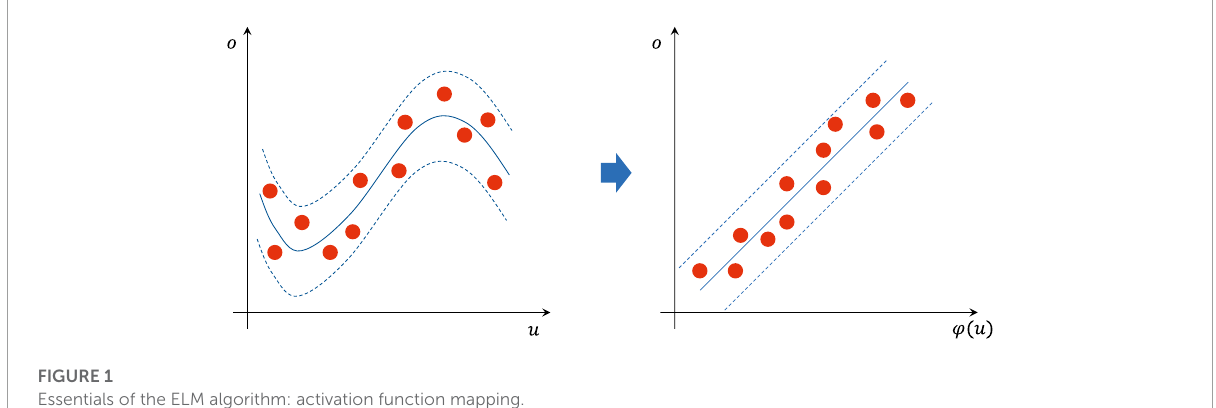
FIGURE 1 Essentials of the ELM algorithm: activation function